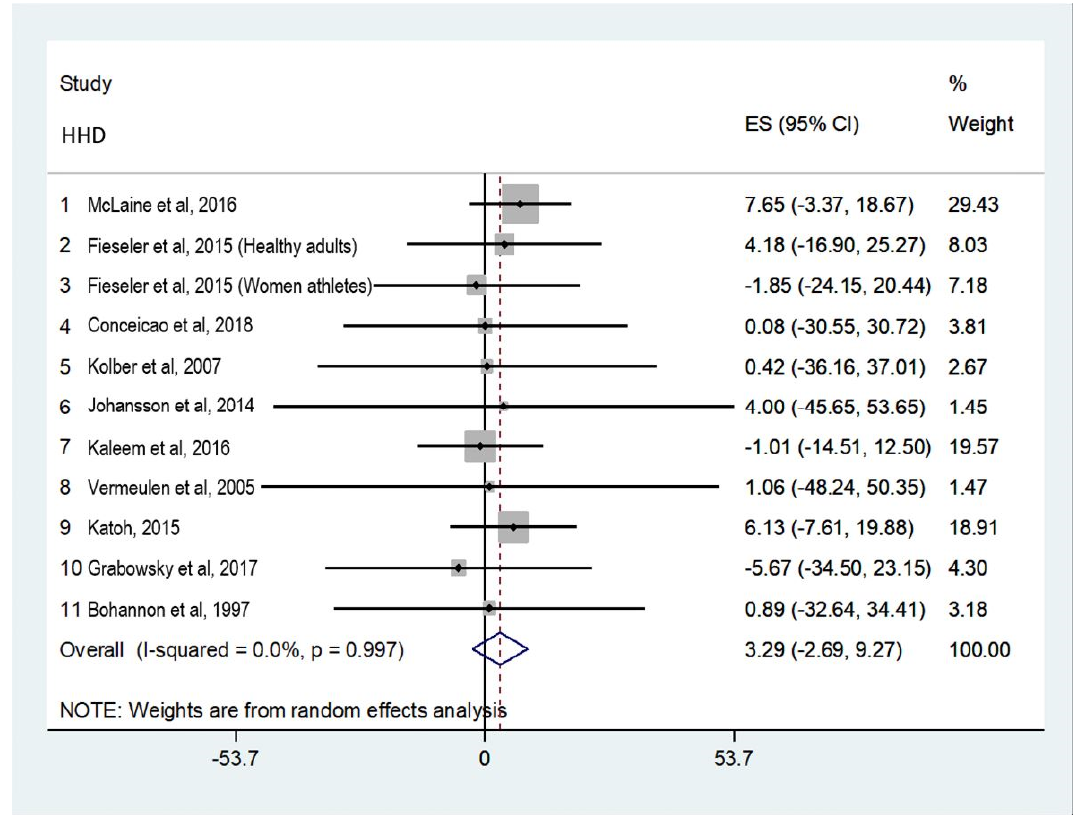
Figure 3. Absolute reliability for shoulder external rotator strength assessment.